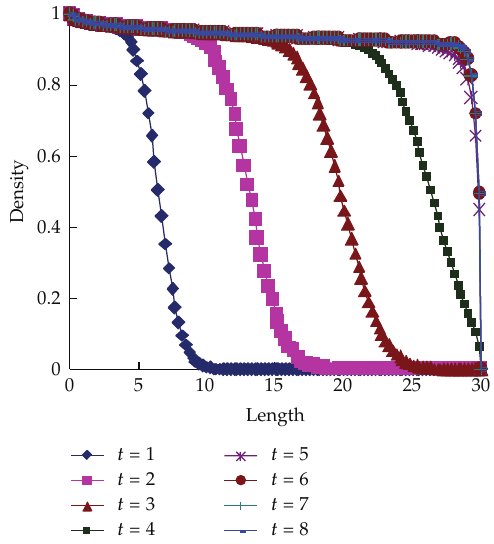
Figure 4: Density along x -axis at di ff erent times with r 1 (cid:10) 0 . 6, r 2 (cid:10) 0 . 2, r 3 (cid:10) 0 . 0, and r 4 (cid:10) 0 . 2.